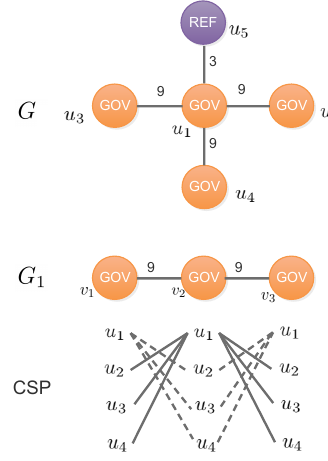
Figure 5. Constraint satisfaction problem (CSP) search space of the subgraph G 1 with the input graph G .